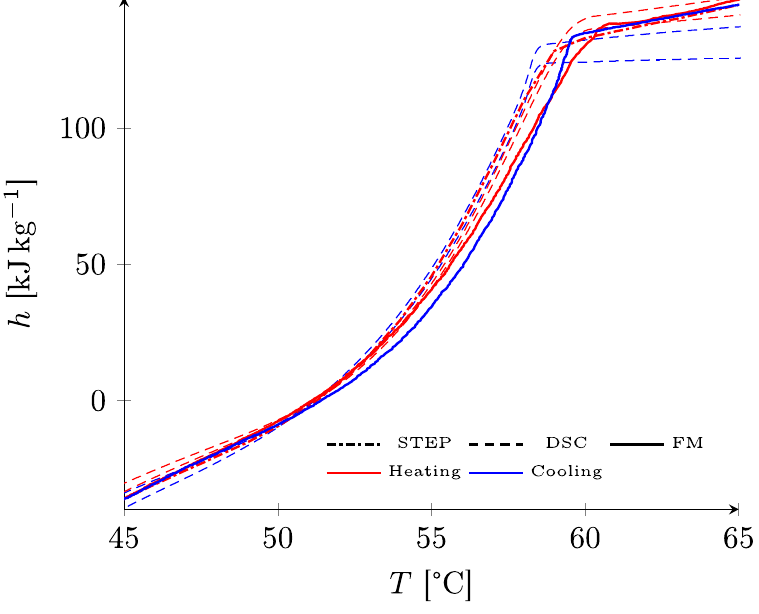
Figure 11. Comparison of the results obtained by the three methods for RT58.